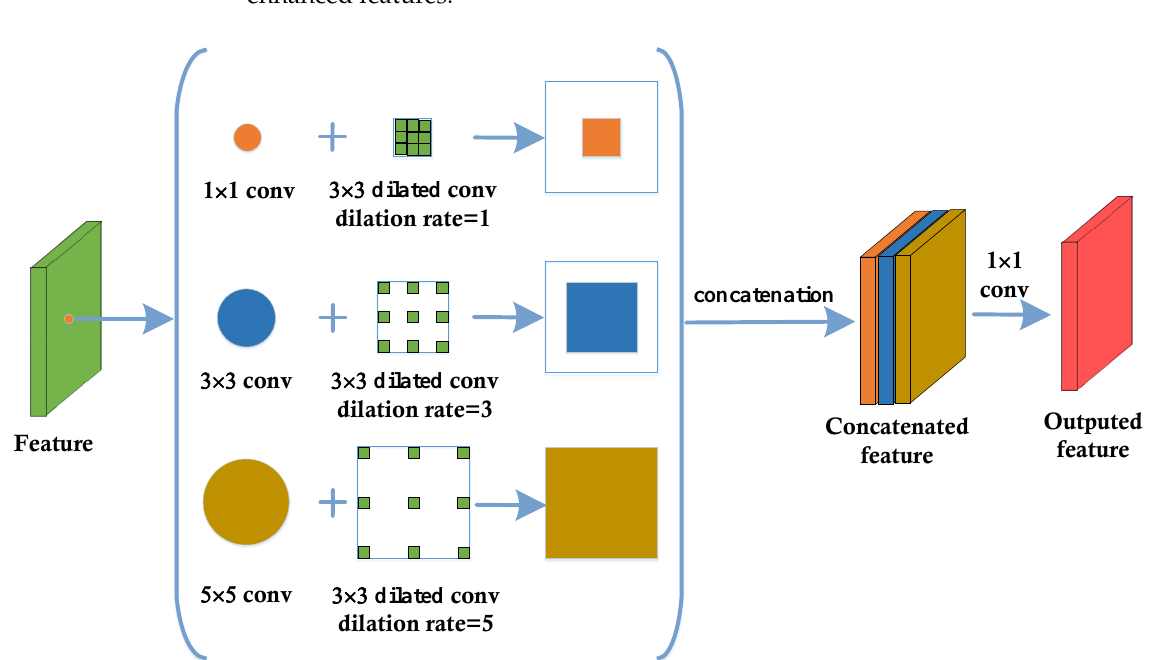
Figure 5. The structure of the proposed cascaded semantic extension module, in which ‘conv’ denotes convolution.